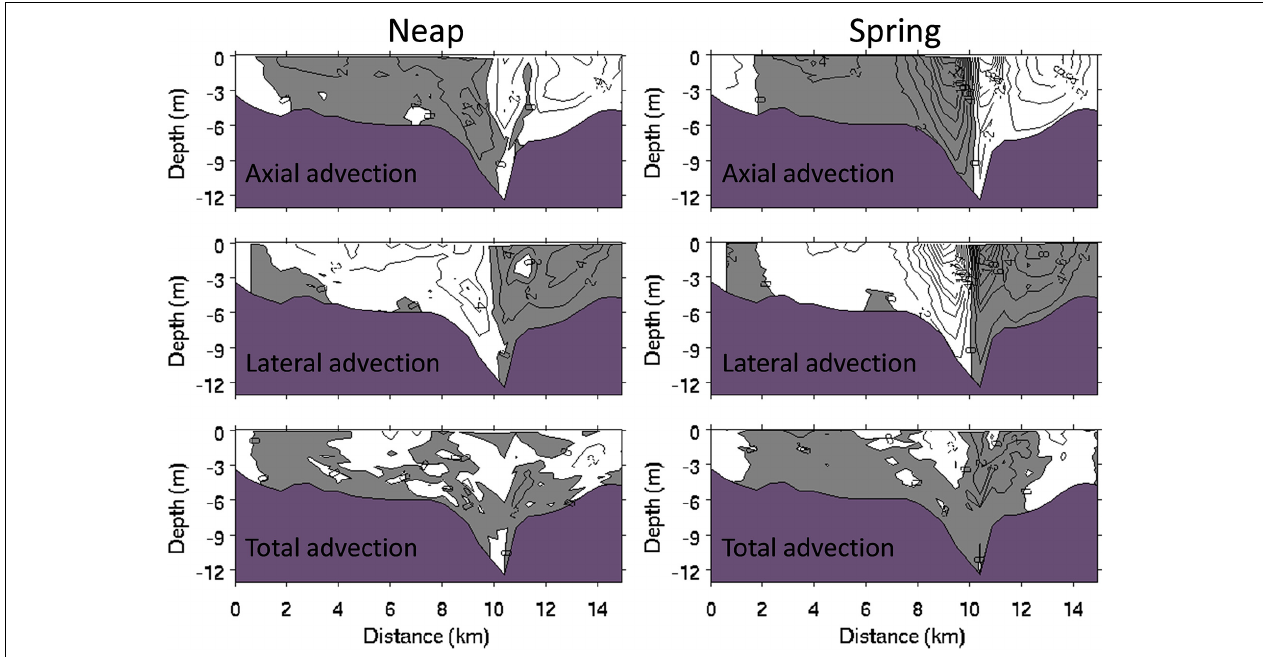
FIGURE 5 | Distributions of the subtidal axial, lateral, and total advections along the cross-channel section S ( × 10 - 5 m 2 /s) at maximal neap and spring tides. Positive value indicates the force toward land. The x-axis represents the distance from the west to the east shoals as one looks into the